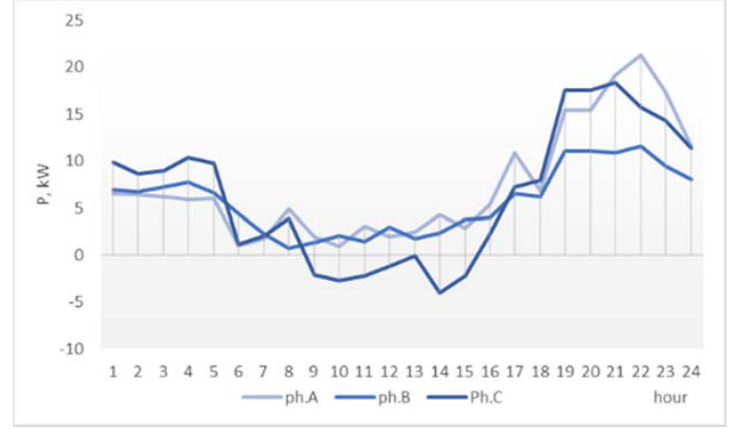
Figure 11. Actual bus demand in network R28 (aggregated demand and generation)—one-phase PSM.